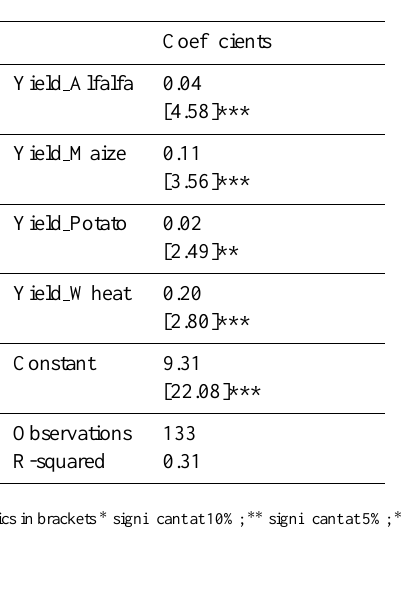
Table 6. Estimated coefficients of profit function (logarithm of the gross added value), robust t-statistics [in brakets] and R 2 .